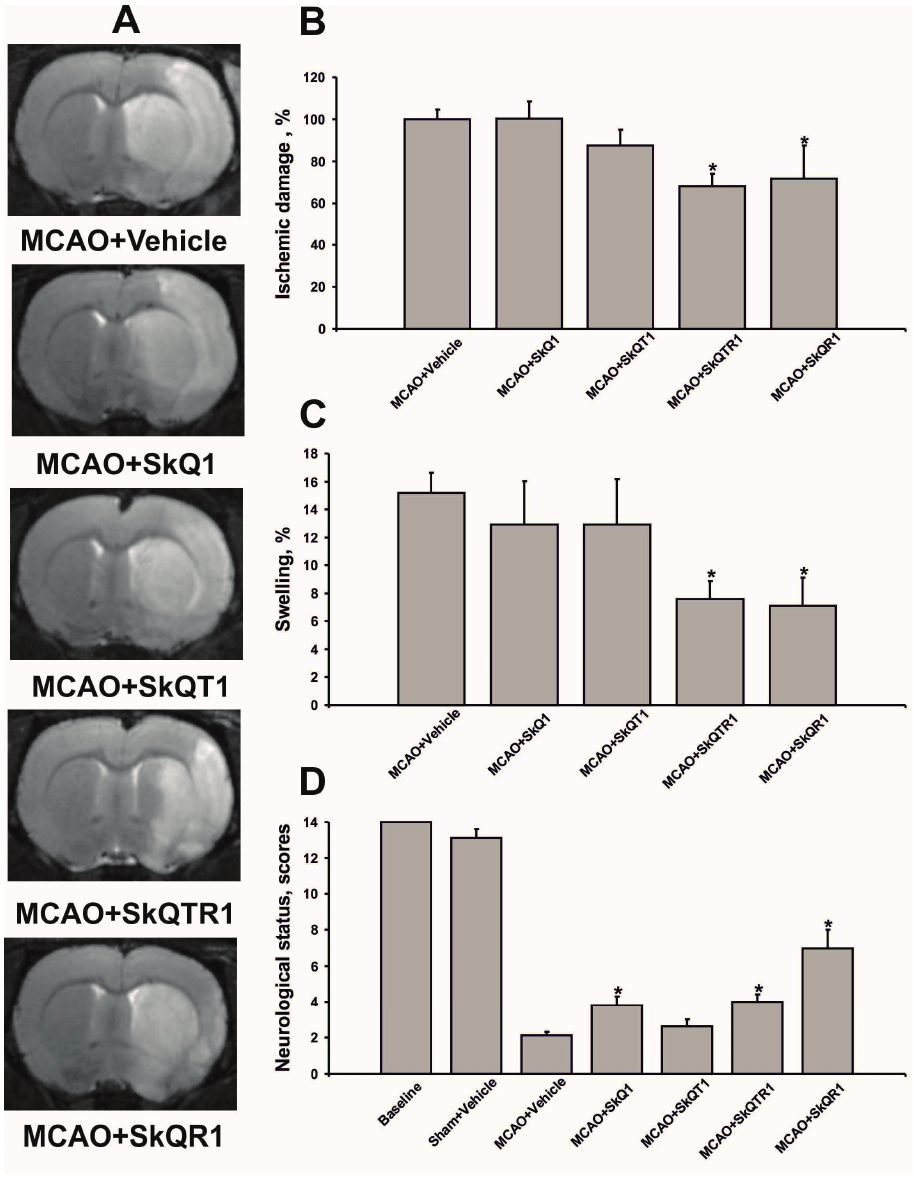
Figure 2. Post-insult mitochondria-targeted antioxidant treatment reduces ischemia/reperfusion-induced brain damage. Animals were subjected to ischemia for 1 h followed by reperfusion for 24 h. The mitochondria-targeted antioxidants were injected i/p immediately after the beginning of reperfusion at a dose of 1 µmol/kg. ( A ) Representative T2-weighted magnetic resonance (MR) images were obtained 24 h after reperfusion onset (each image covered an 0.8 mm thick brain section). Hyperintense regions in the right hemisphere (shown as more light area) refer to ischemic areas; ( B ) Infarct volume and ( C ) brain edema (swelling) evaluated by using magnetic resonance imaging (MRI) with analysis of T2-weighted images; ( D ) Neurological status estimated using limb-placing test. * denotes significant difference from the MCAO + Vehicle group ( p < 0.05) (One-way ANOVA, followed by Tukey’s post hoc analysis for ( B , C ); Kruskal-Wallis test with the Mann-Whitney u -test for ( D